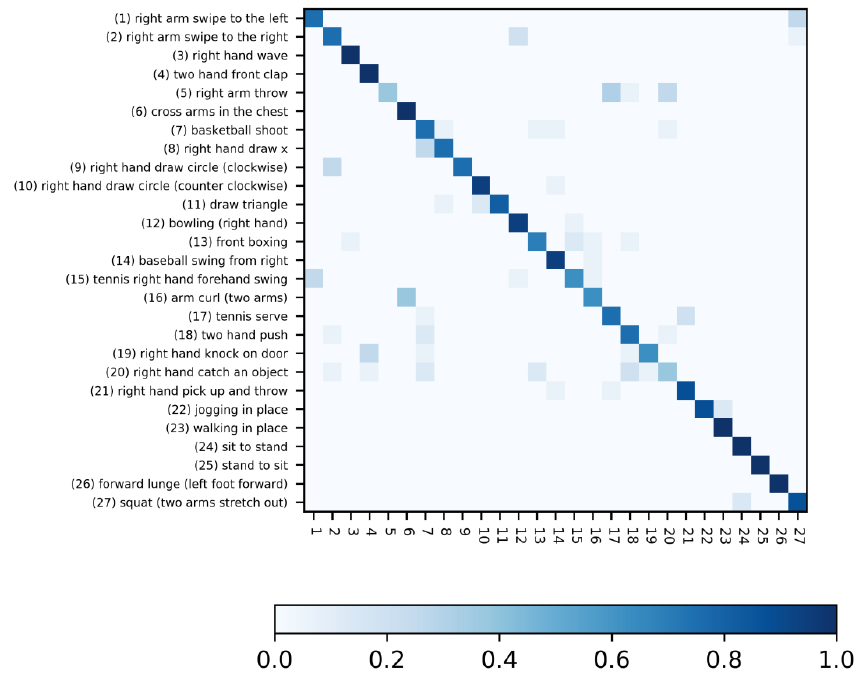
Figure 7. Confusion matrix obtained using the one-vs.-all discriminating